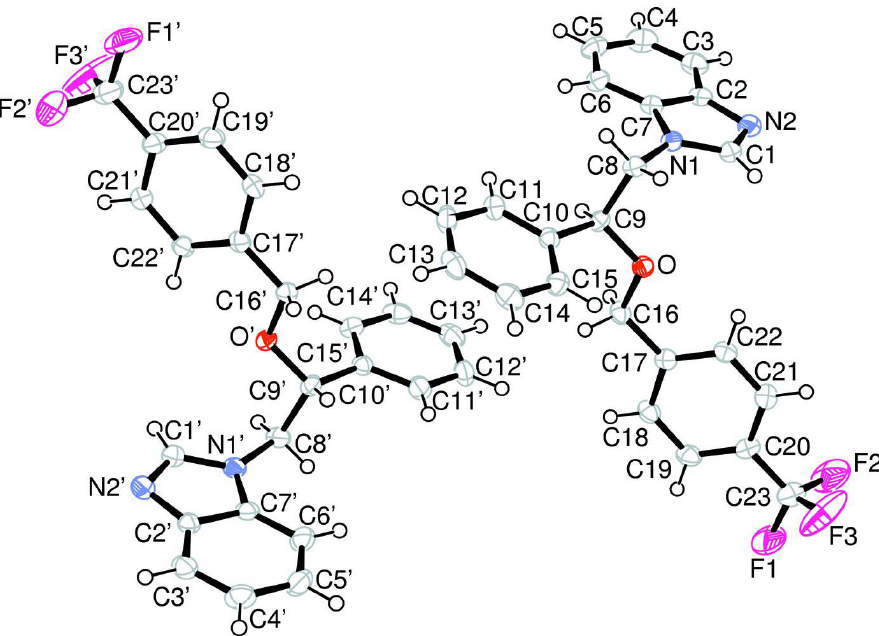
Figure 1 The molecular structure of the title molecule with the atom-numbering scheme. Displacement ellipsoids are drawn at the 50% probability level.